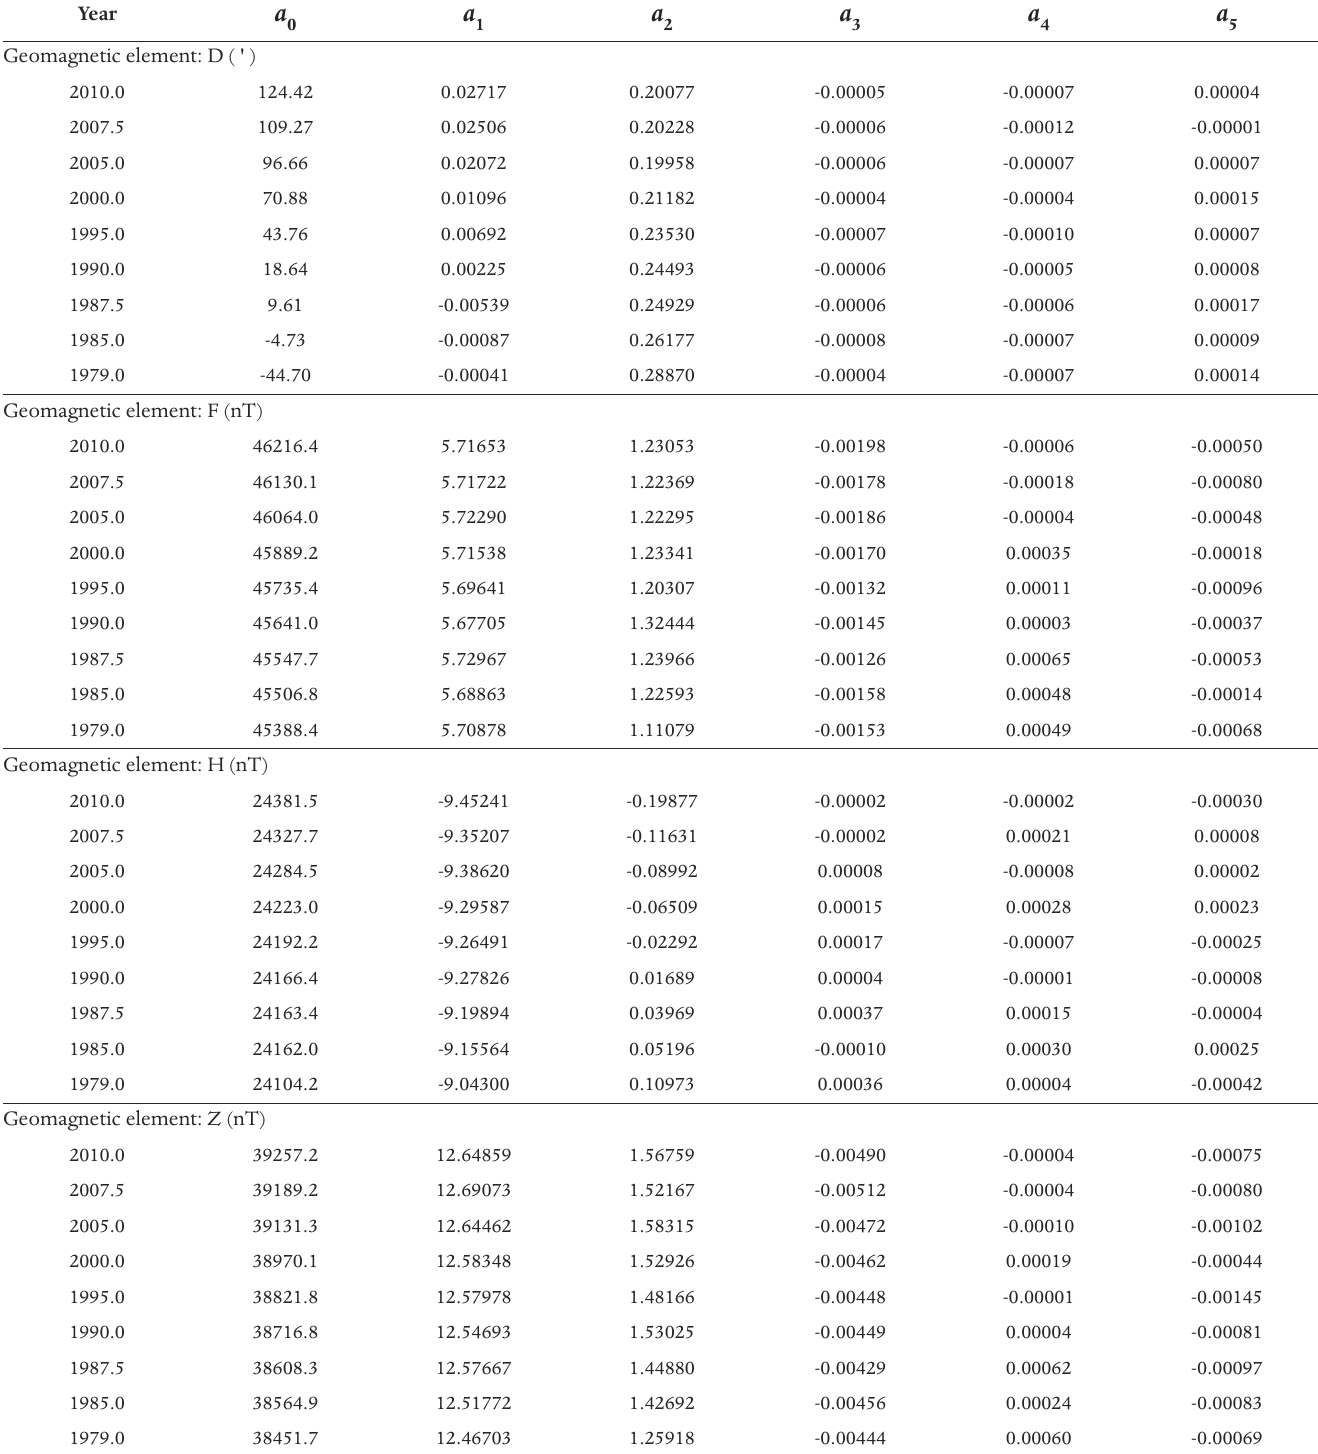
Table 2. Coefficients of normal fields for epochs from 1979 to 2010 for all magnetic elements. Latitude z and longitude m are referred to 42˚ N and 12˚ E respectively, with values expressed in minutes of arc. z = (Lat. − 42˚) in minutes; m = (Long. − 12˚) in